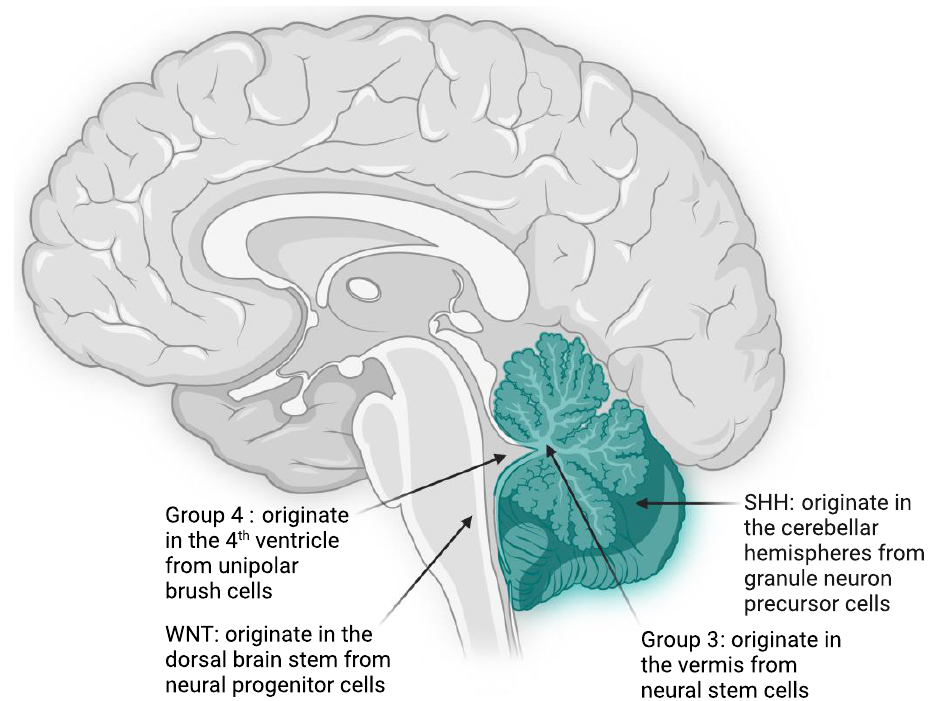
Figure 1. Origin of medulloblastoma tumors. Schematic showing the subgroup-specific origination and precursor cell for medulloblastoma tumors. Cerebellum is depicted in teal color. WNT, wingless subgroup; SHH, sonic hedgehog subgroup.